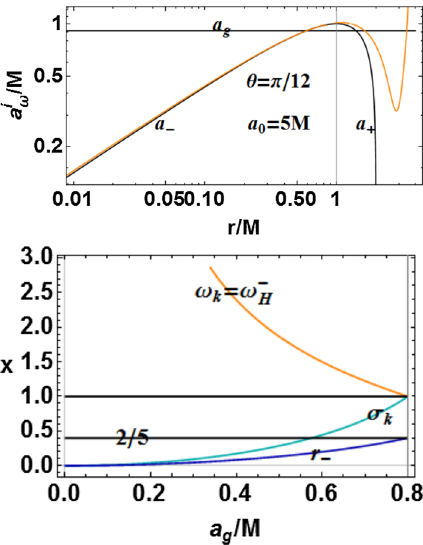
Fig. 23 Upper: metric bundle for the origin spin a 0 = 5 M and plane θ = π/ 12. The black line is the tangent spin of the bundle (orange) to the horizon curve a ± (black) on the extended plane. It shows also the existence of minimum of the bundle curve with spin lower than the tangent spin. The full extension of this bundle is depicted in Fig. 6. Below panel: limiting plane σ k , frequency ω k = ω − (inner horizon H frequency on the extended plane), the inner horizon r − as function of the tangent spin a g . Based on the analysis of Eqs. (82) and